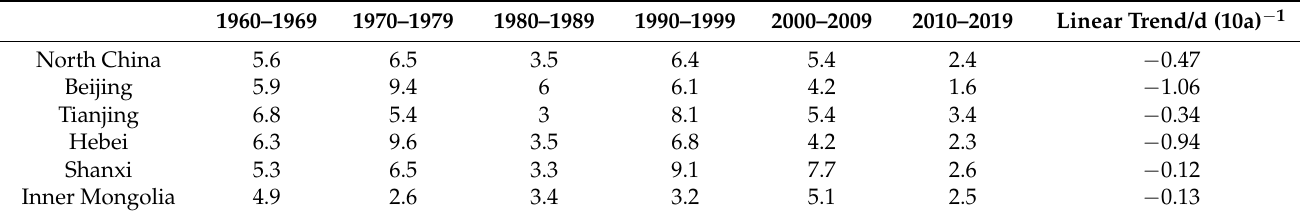
Table 5. Decadal average and linear trend rate of Extreme drought days for North